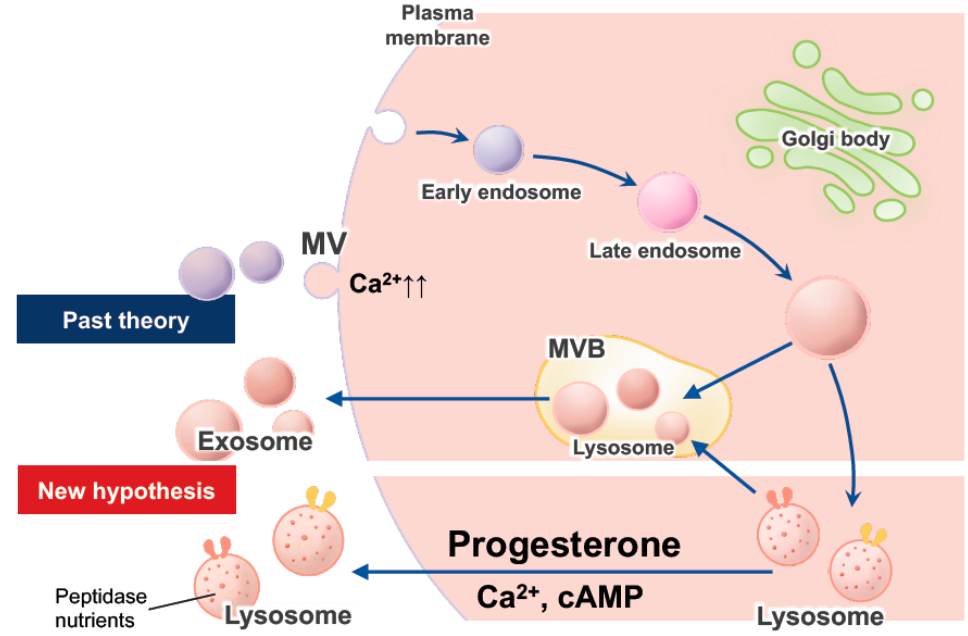
Figure 2. Schematic representation of the dynamics of the endolysosomal system and exocytosis of lysosomes. EVs derived from EECs and treated with both estradiol and progesterone were